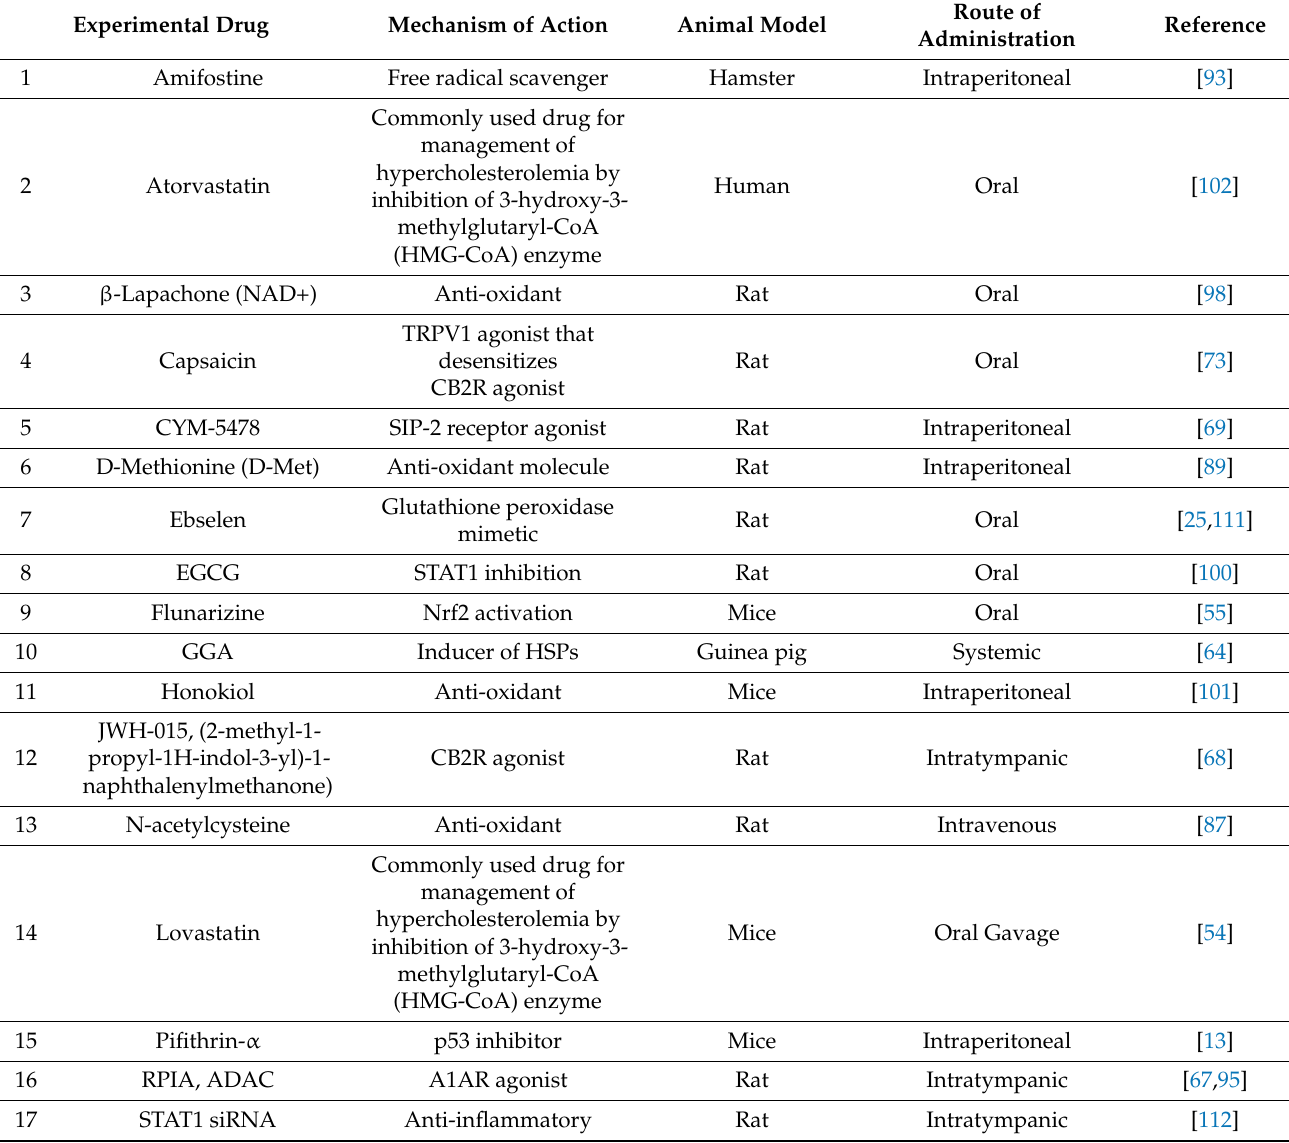
Table 1. Potential drugs and their targets for the treatment of cisplatin ototoxicity. Experimental Drug Mechanism of Action Animal Model